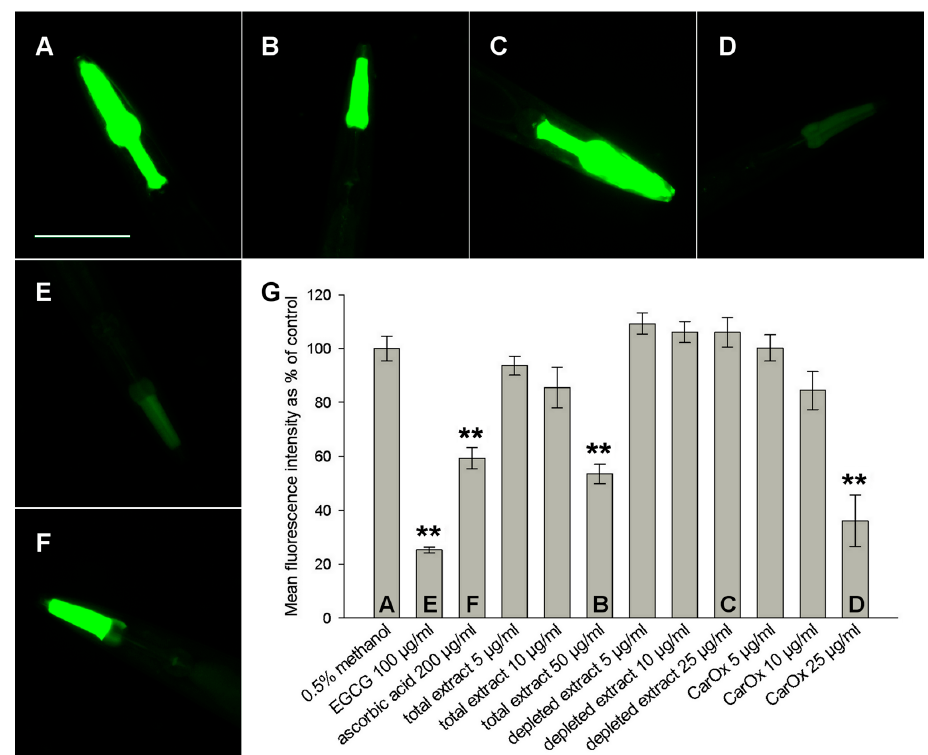
Figure 2. Heat shock protein (HSP) expression assay in C. elegans . A–F: representative pictures of GFP fluorescence in worms treated with 0.5% methanol ( A ; negative control); 50 μ g/mL total extract of C. acaulis ( B ); 25 μ g/mL depleted extract ( C ); 25 μ g/mL CarOx ( D ); 100 μ g/mL ( − )-epigallocatechin gallate (EGCG) ( E ; positive control); and 200 μ g/mL ascorbic acid ( F ; positive control); ( G ) quantification of the fluorescence intensity for respective treatments. Pictures taken with BZ9000 from Keyence, scale bar = 100 μ m. ** p < 0.01 compared to the negative control.